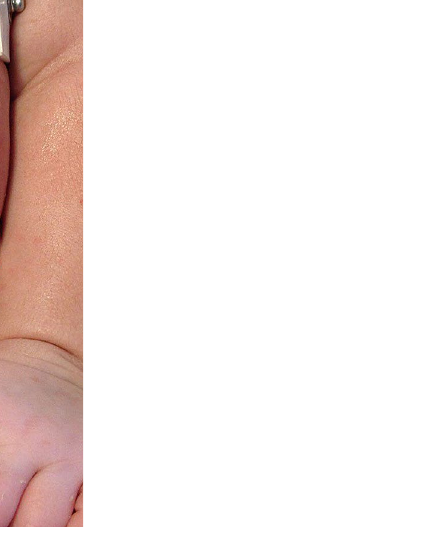
Figure 3. Phase 2 or definitive closure of the